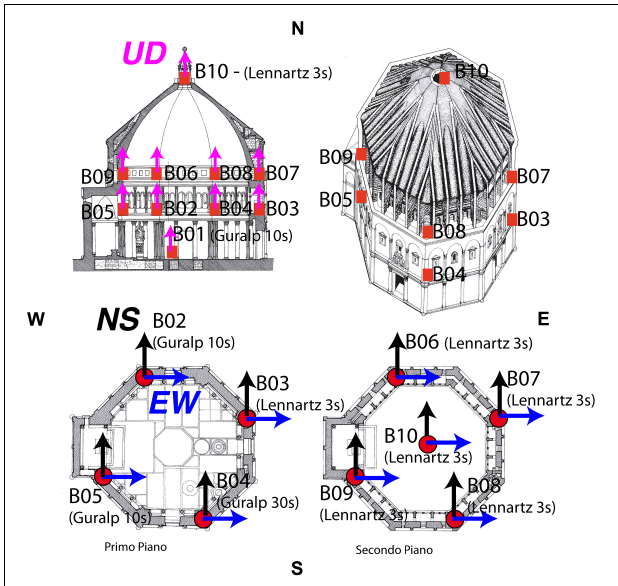
FIGURE 3 | (a) Average of modal coherence. (b) Standard deviation of modal coherence. (c) First singular values calculated for the 42 h (Lacanna et al., 2016).